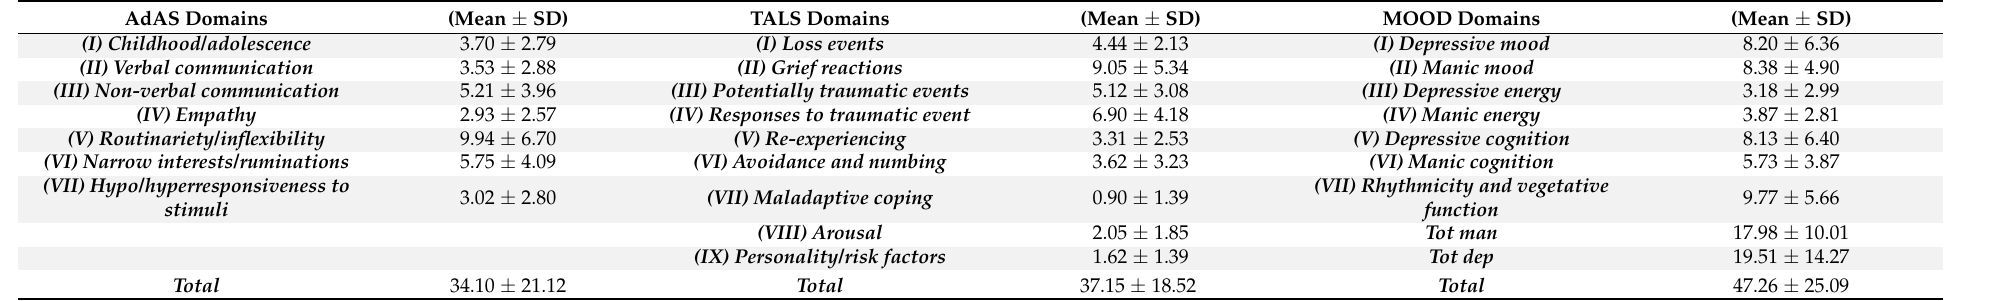
Table 2. AdAS, TALS, and MOOD single and total domains’ mean ( ± SD) scores (N = 325).